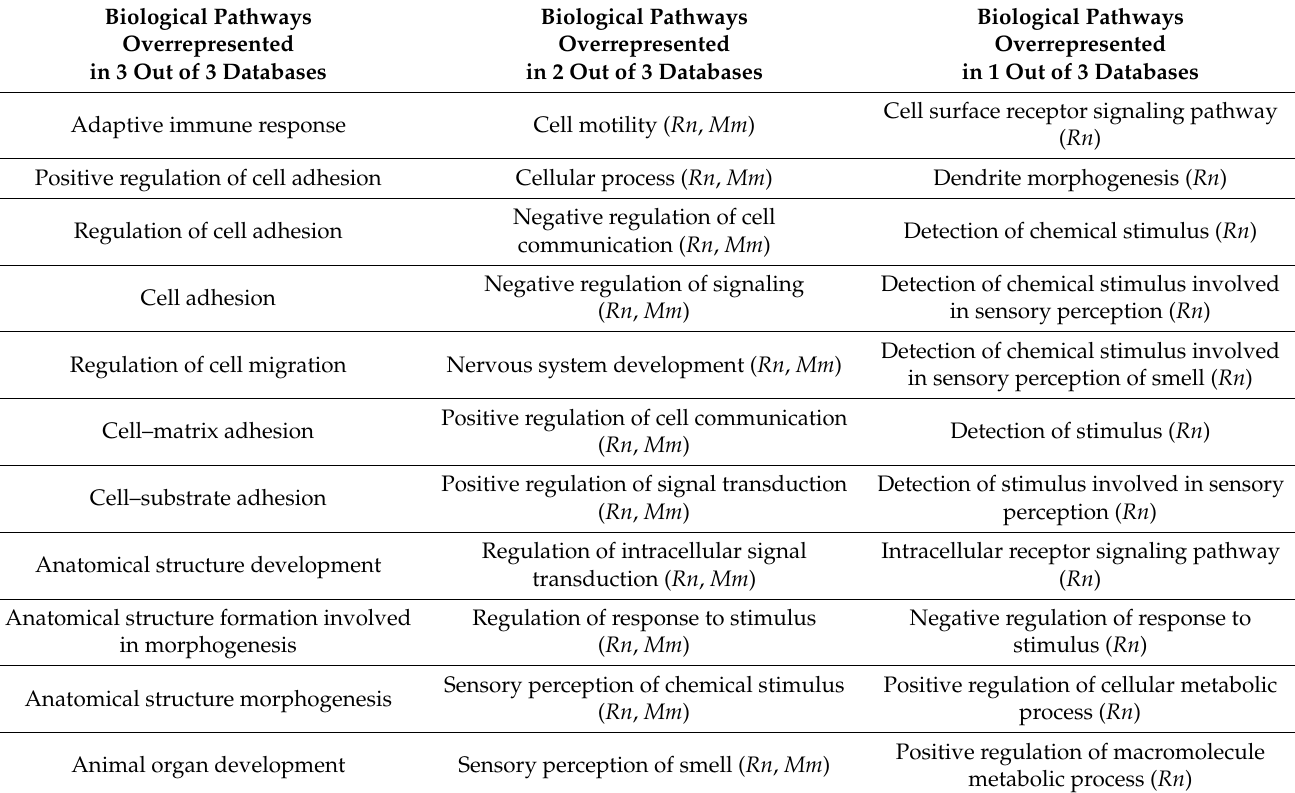
Table 1. Selected “biological process” terms significantly overrepresented in Fil050G and Fil125G after 10 days of implantation in the Homo sapiens ( Hs ), Mus musculus ( Mm ), and Rattus norvegicus ( Rn )